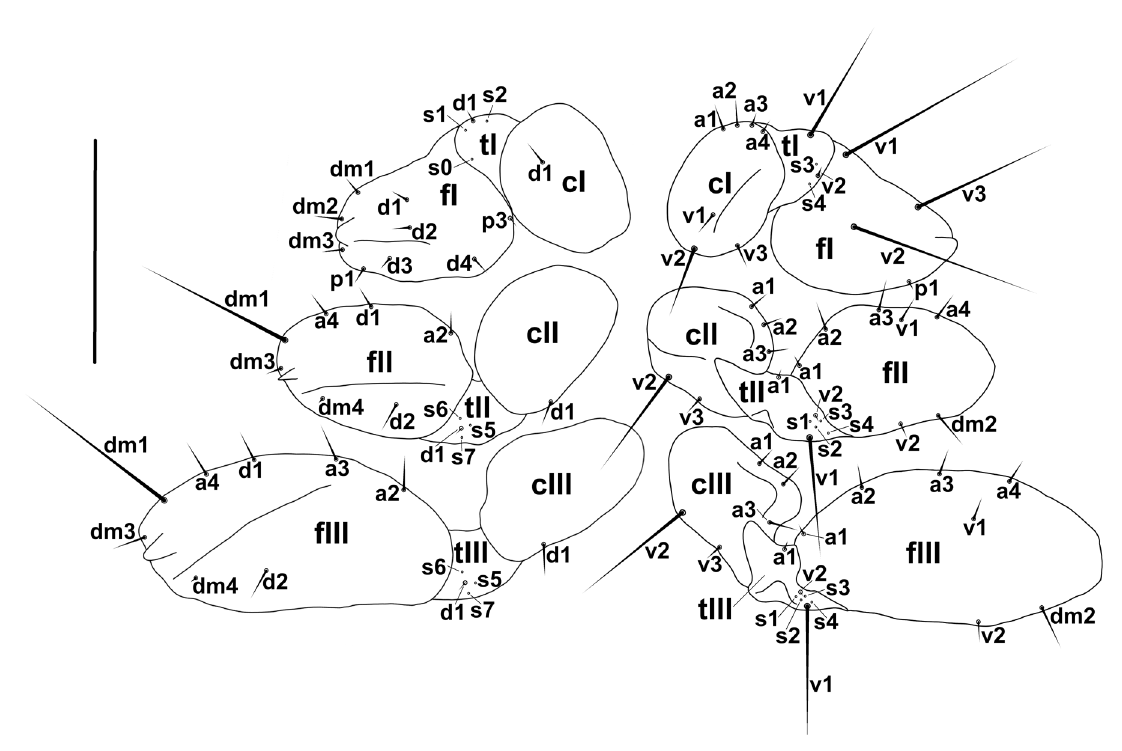
Fig. 7. Philopterus gustafssoni sp. nov. ex Regulus regulus (MMBC CZ-OS01): nomenclature of male leg chaetotaxy, dorsal and ventral views. Abbreviations: c – coxa; t – trochanter; f – femur; dm – distal marginal seta; d – dorsal seta; a – anterior seta; p – posterior seta; s – sensillus; v – ventral seta. Scale bar: 0.1